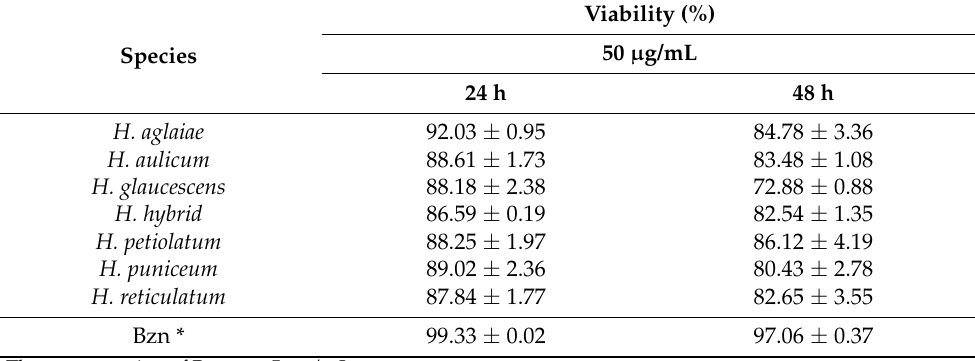
Table 4. In vitro activity of Hippeastrum spp. BAREs from Argentina on viability of T. cruzi epimastig- otes (mean ±